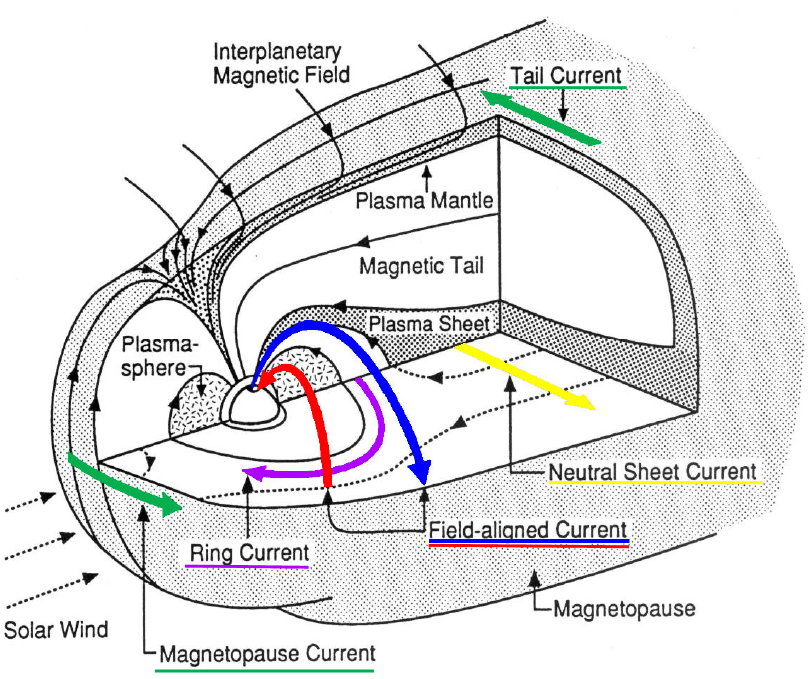
Figure 4. Electric currents in the magnetosphere (from the GEM source book 1999 [23]).